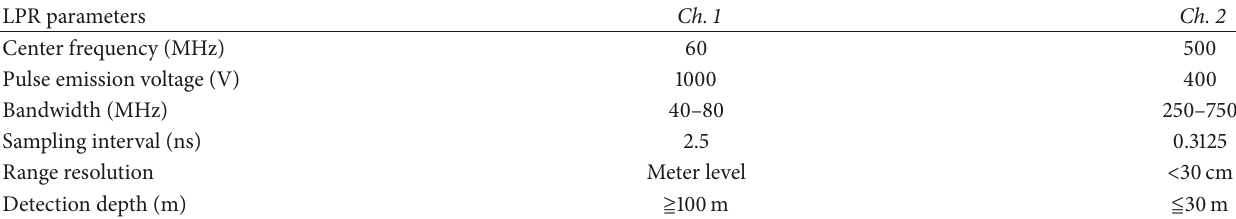
Table 1: Basic parameters of lunar penetrating